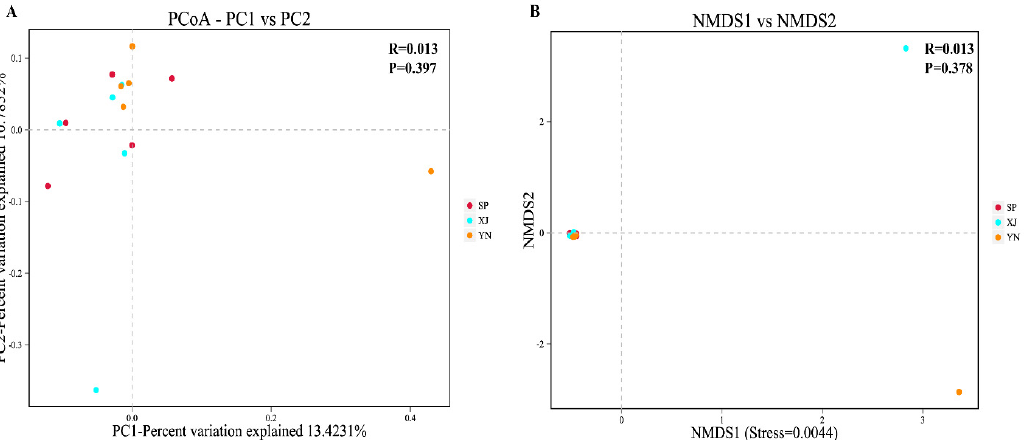
Figure 4. Beta diversity analysis of T. absoluta from different locations. Abbreviations: SP, Spain; XJ, Xinjiang; YN, Yunnan. ( A ) Principal coordinates analysis (PCoA) and ( B ) nonmetric multidimensional scaling (NMDS) based on the binary Jaccard distance. The reliability of NMDS with a stress value less than 0.2 is acceptable.